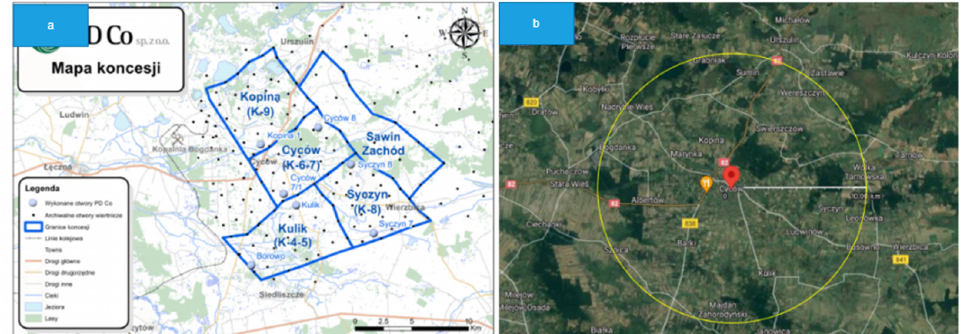
Figure 5. The locations of the K-6 and K-7 deposits ( a ) and the outlined mapping area ( b ). Source: on the right—the authors’ own study based on Google Maps; on the left—PDCo Sp. z o.o.